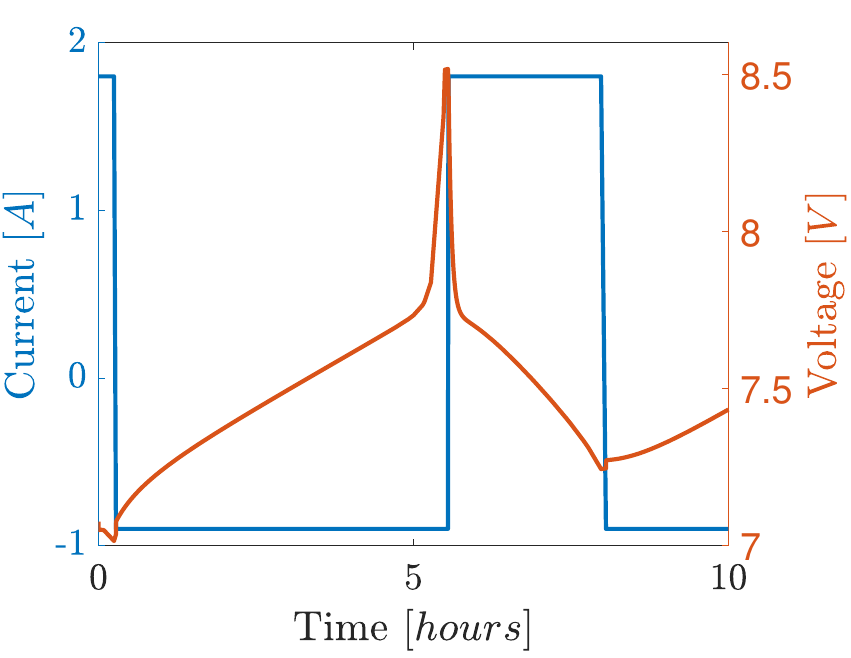
Figure 10. Charge/discharge profile: current and voltage.